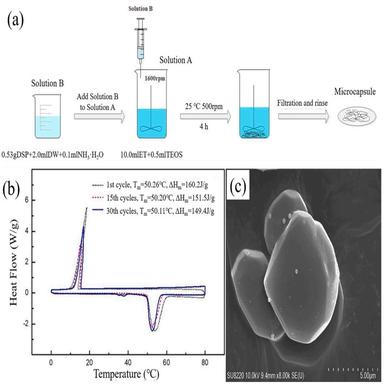
(a) Schematic illustration of Na2HPO4⋅7H2O@SiO2 MEPCM prepared by one-pot method, (b) DSC curves of Na2HPO4⋅7H2O@SiO2 MEPCM after meltingfreezing cycling experiment and (c) SEM image of Na2HPO4⋅7H2O@SiO2 MEPCM after 30 thermal cycles. Reproduced with the permission of Elsevier.